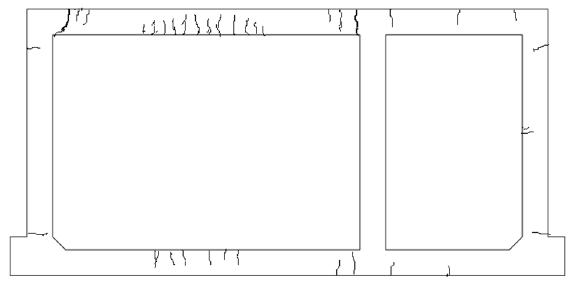
Figure 9. Crack profile of the full-scale model.